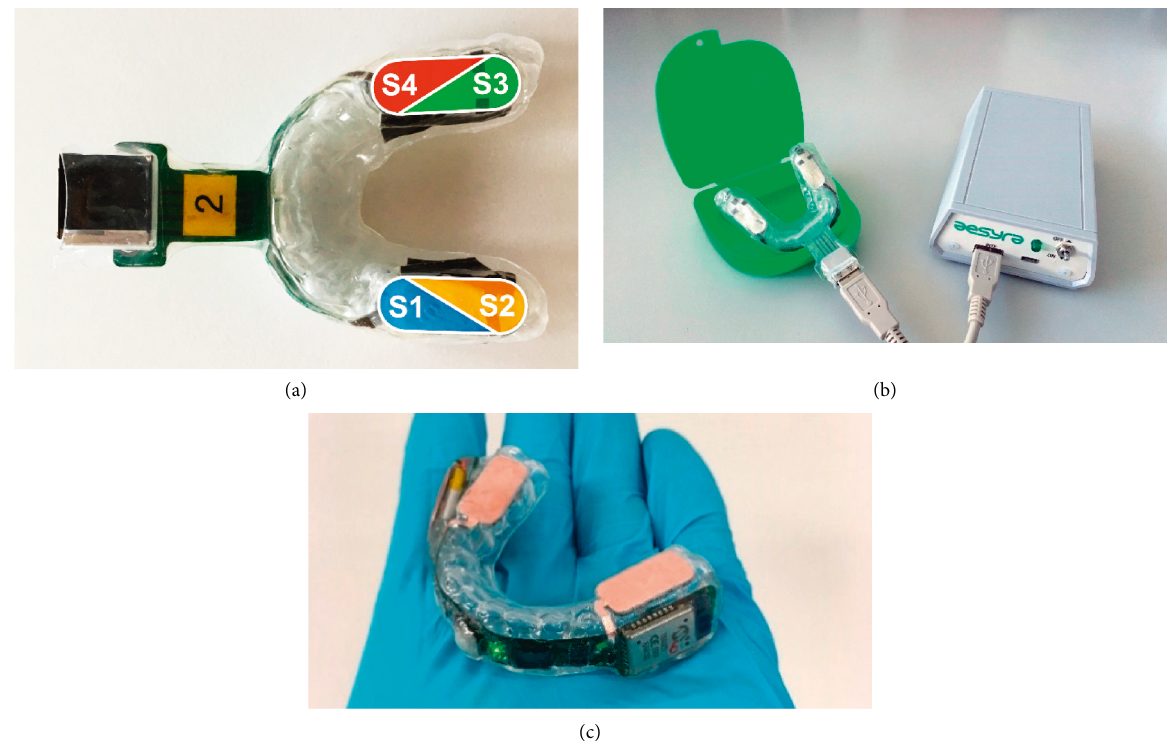
Figure 1: (a) Sensor placement in the prototype bite. (b) First generation prototype used in test #2. (c) Second generation (wireless) prototype used in test